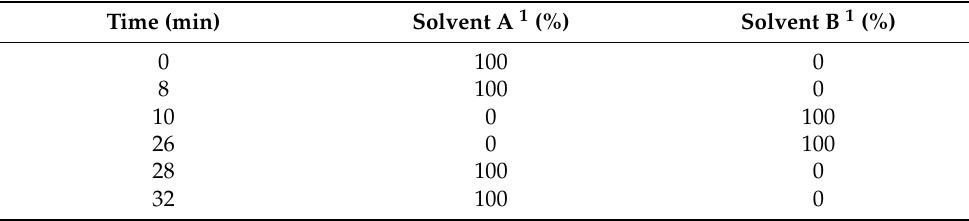
Table 1. HPLC elution gradient used for chlorophyll and carotenoid analysis. Time (min) Solvent A 1 (%) Solvent B 1